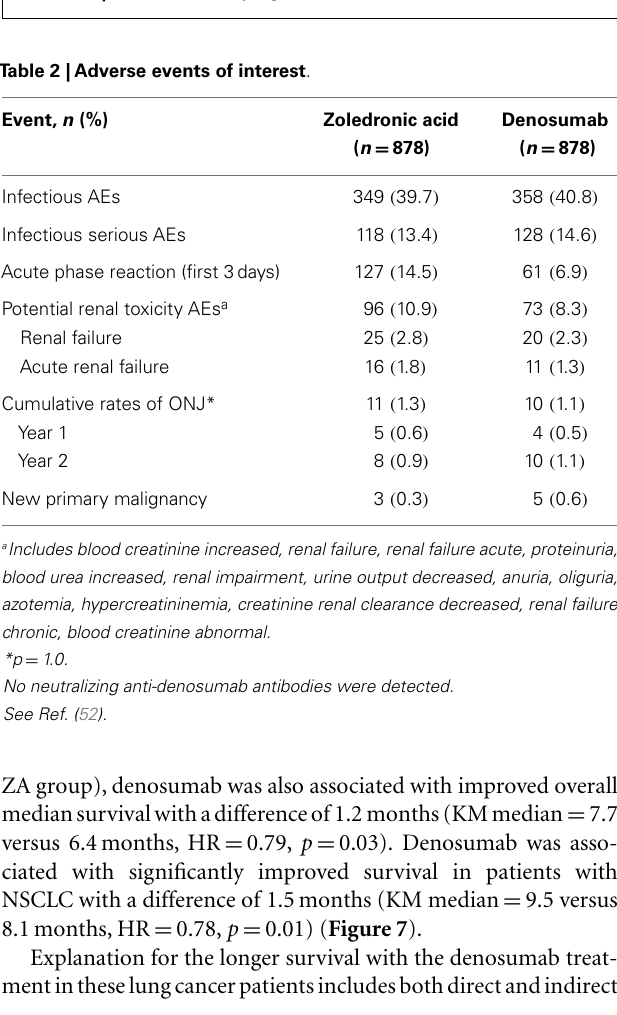
FIGURE 5 | Overall disease progression (52).